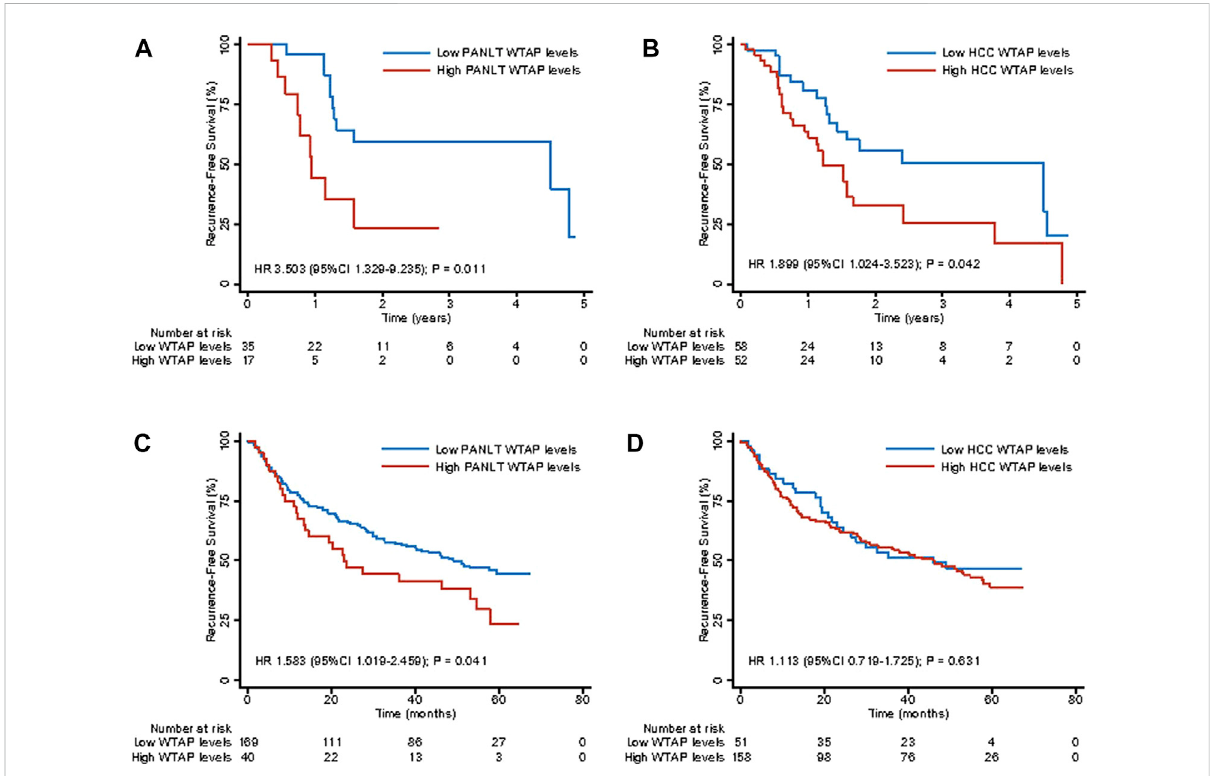
FIGURE 4 Kaplan-Meier survival curves for recurrence-free survival for high and low WTAP expression levels of liver tissue and HCC in external extension cohort of Singapore [ (A,B) , respectively] and Shanghai [ (C,D) , respectively]. Abbreviations: HCC, hepatocellular carcinoma.